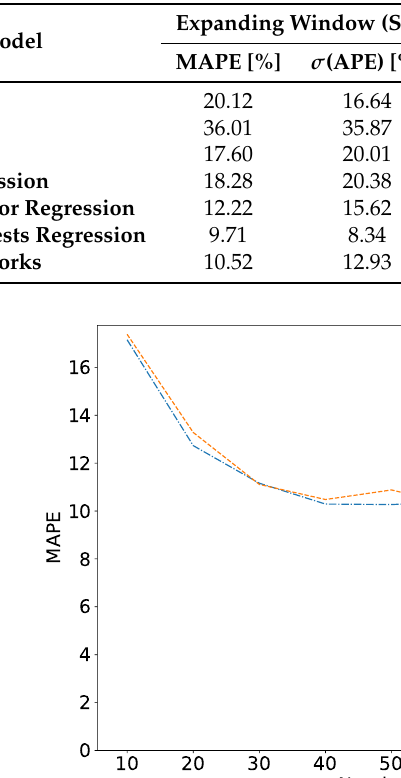
Table 2. Short-term temporal prediction—Mean Absolute Percentage Error (MAPE), Absolute Percentage Error (APE), and Root Mean Squared Error (RMSE), for each prediction model in the validation set.